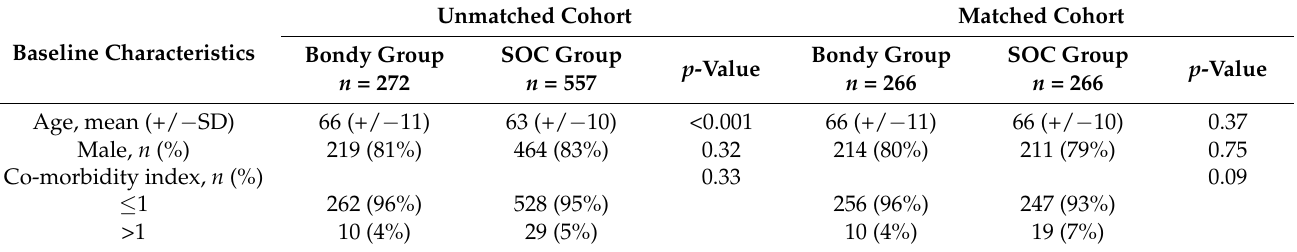
Figure 2. Consort diagram of study flow and the selection of patients for inclusion. The two groups were matched based on a 1:1 propensity score using an optimal matching program. HCC, Hepatocellular carcinoma; TACE, trans-arterial chemoembolization; TARE, trans-arterial radioembolization. Table 1. Baseline characteristics of the unmatched and matched cohort and treatment